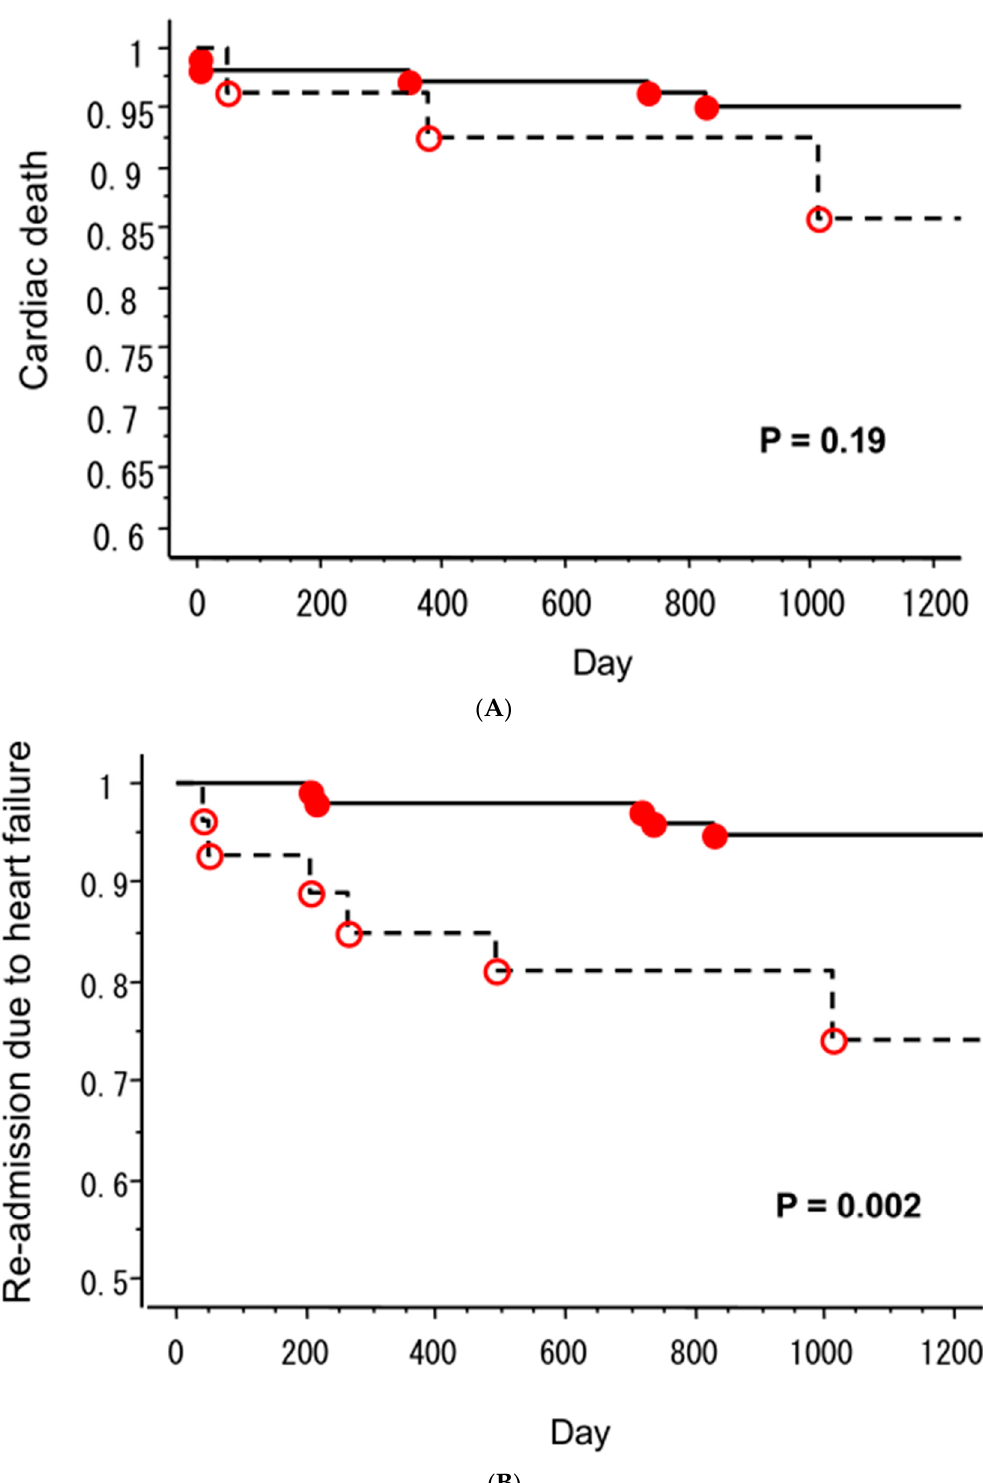
Figure 4. Long-term prognosis of the STEMI patients with and without hyponatremia 72 h after hospitalization. The Kaplan–Meier curve estimates the long-term occurrence of cardiac death ( A ) and rehospitalization due to heart failure ( B ). In patients with hyponatremia, the incidence of cardiac death showed a higher trend ( A ), and the incidence of re-admission due to worsening heart failure was significantly greater than that in the patients without hyponatremia ( B ). ⚫ , patients with hyponatremia; ◯, patients with normonatremia 72 h after hospitalization. Cited from Ref. [5].